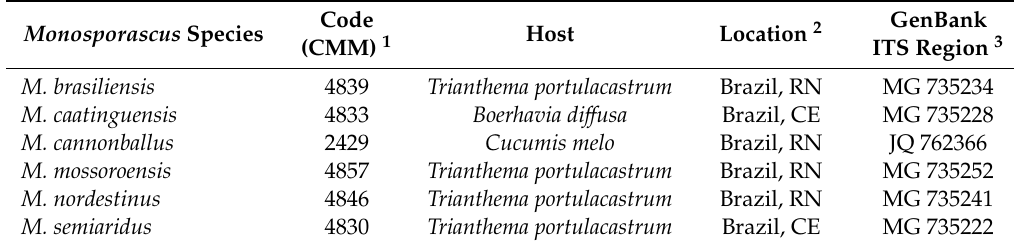
Table 1. Isolates of the Monosporascus spp. used in this